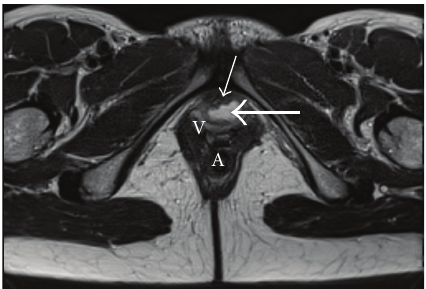
Figure 5: The big perineal defect and the extent of theanal sphincter injury are clear. The anal mucosa has already been closed at the time of initial debridement.